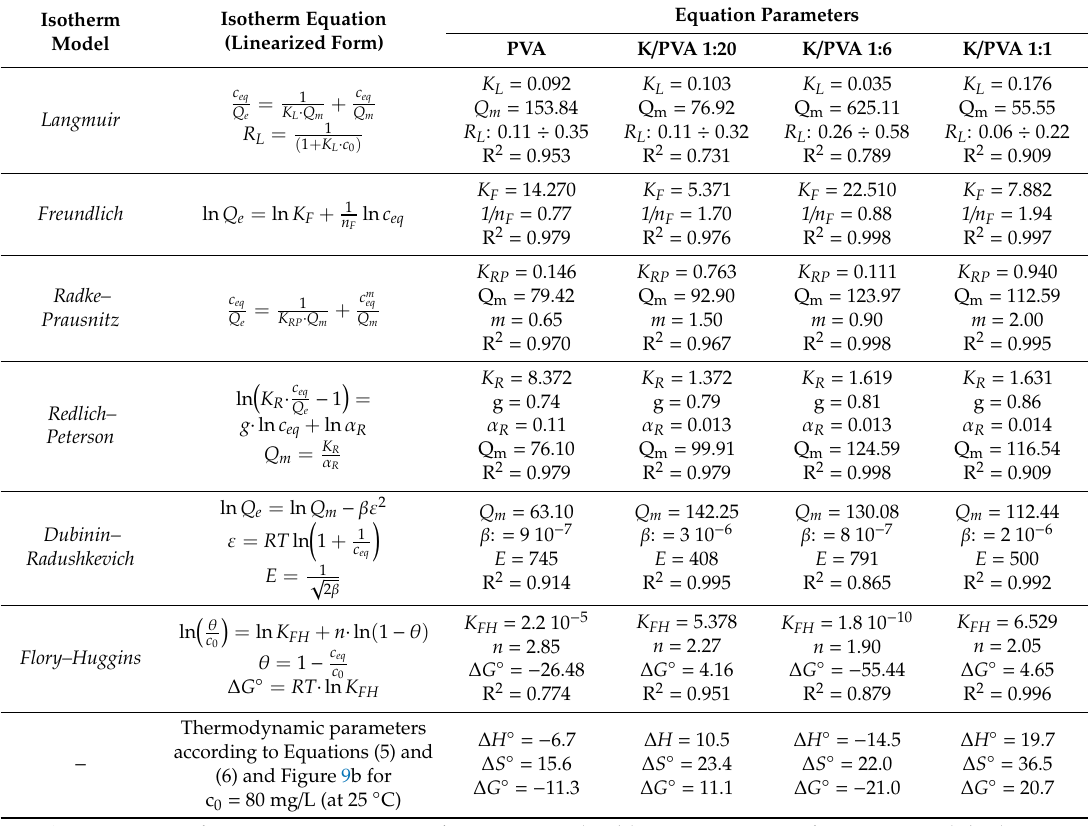
Table 5. Parameters of the isotherm models fitted onto the experimental CV adsorption data at 25 ◦ C. Isotherm Equation Isotherm (Linearized Model